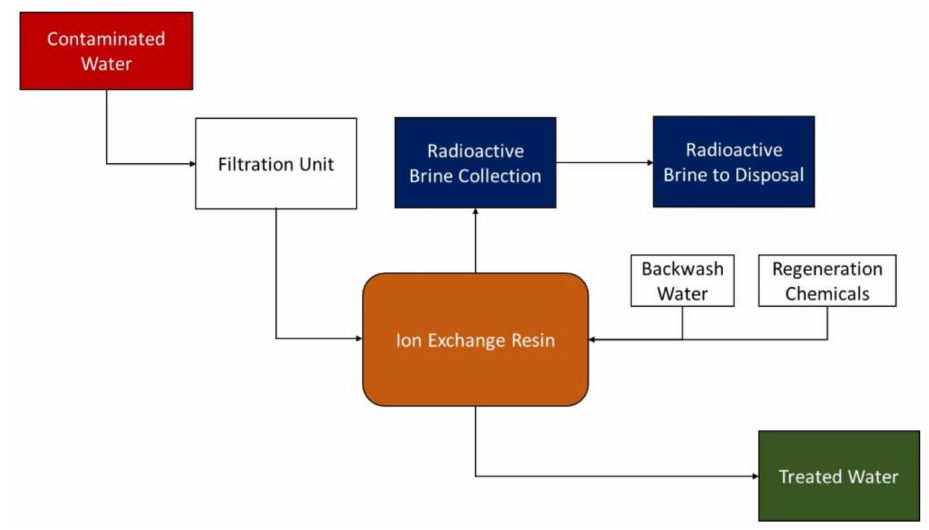
Figure 1. The general process involved in ion exchange